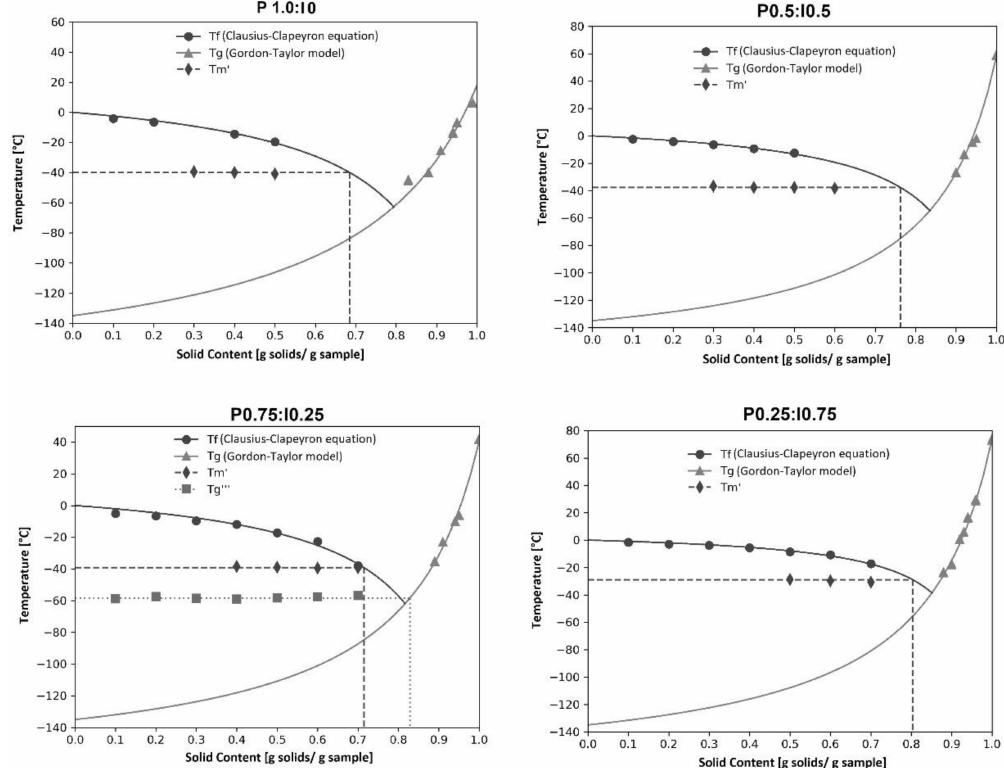
Figure 4. State diagrams of pumpkin–inulin freeze-dried pumpkin, P1:I0 data from ref. [9]. Constant, molecular weight and proper coefficient of the determination values cal-